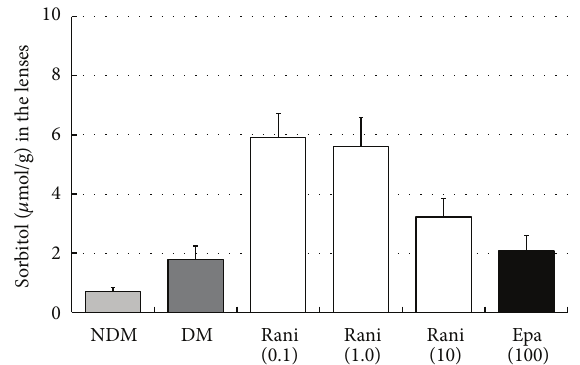
Figure 8: The sorbitol levels in the lenses at 40 weeks. Although there seems to be a dose-dependent decrease in the sorbitol levels in the lenses with administration of ranirestat, the sorbitol levels in the untreated lenses and in those treated with epalrestat are very low. NDM: non-diabetes mellitus; DM: diabetes mellitus; rani: ranirestat; epa: epalrestat.